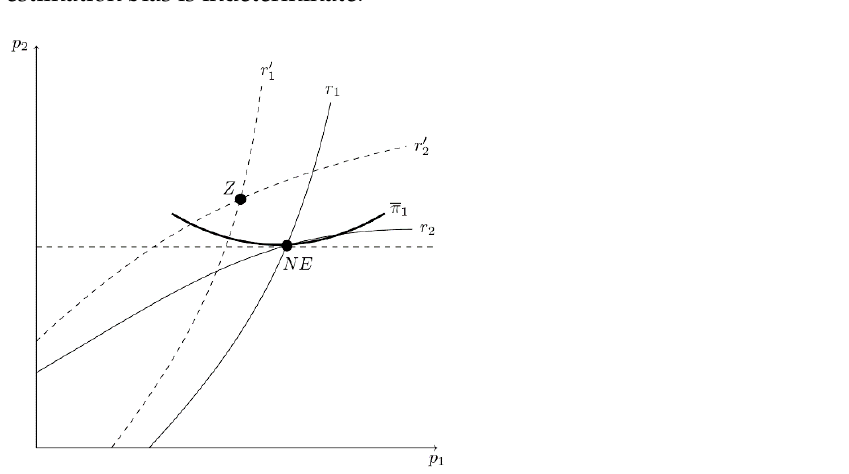
Figure 9. The SPNE When Owners Hire CEOs Who Underestimate Product Substitutability in the Bertand Model.